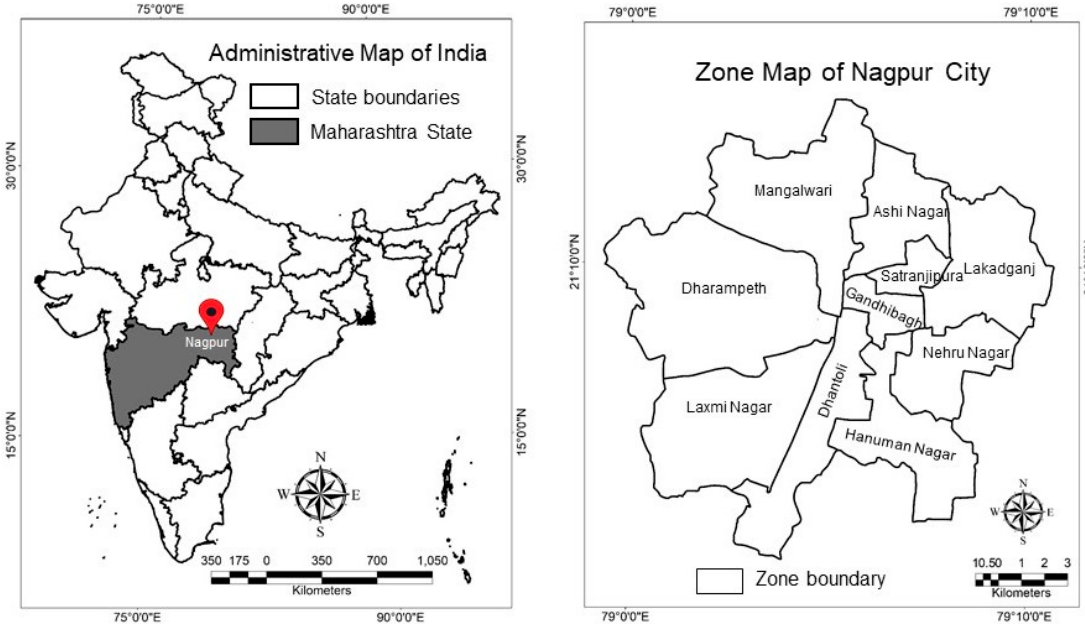
Figure 1. Location Map of Nagpur city in Maharashtra State of India (Image source: Author).